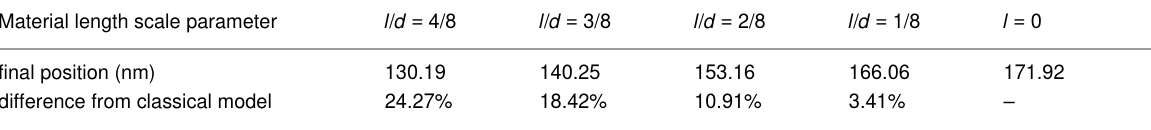
Table 13: Final position of the polystyrene nanorod using a nonclassical Timoshenko beam